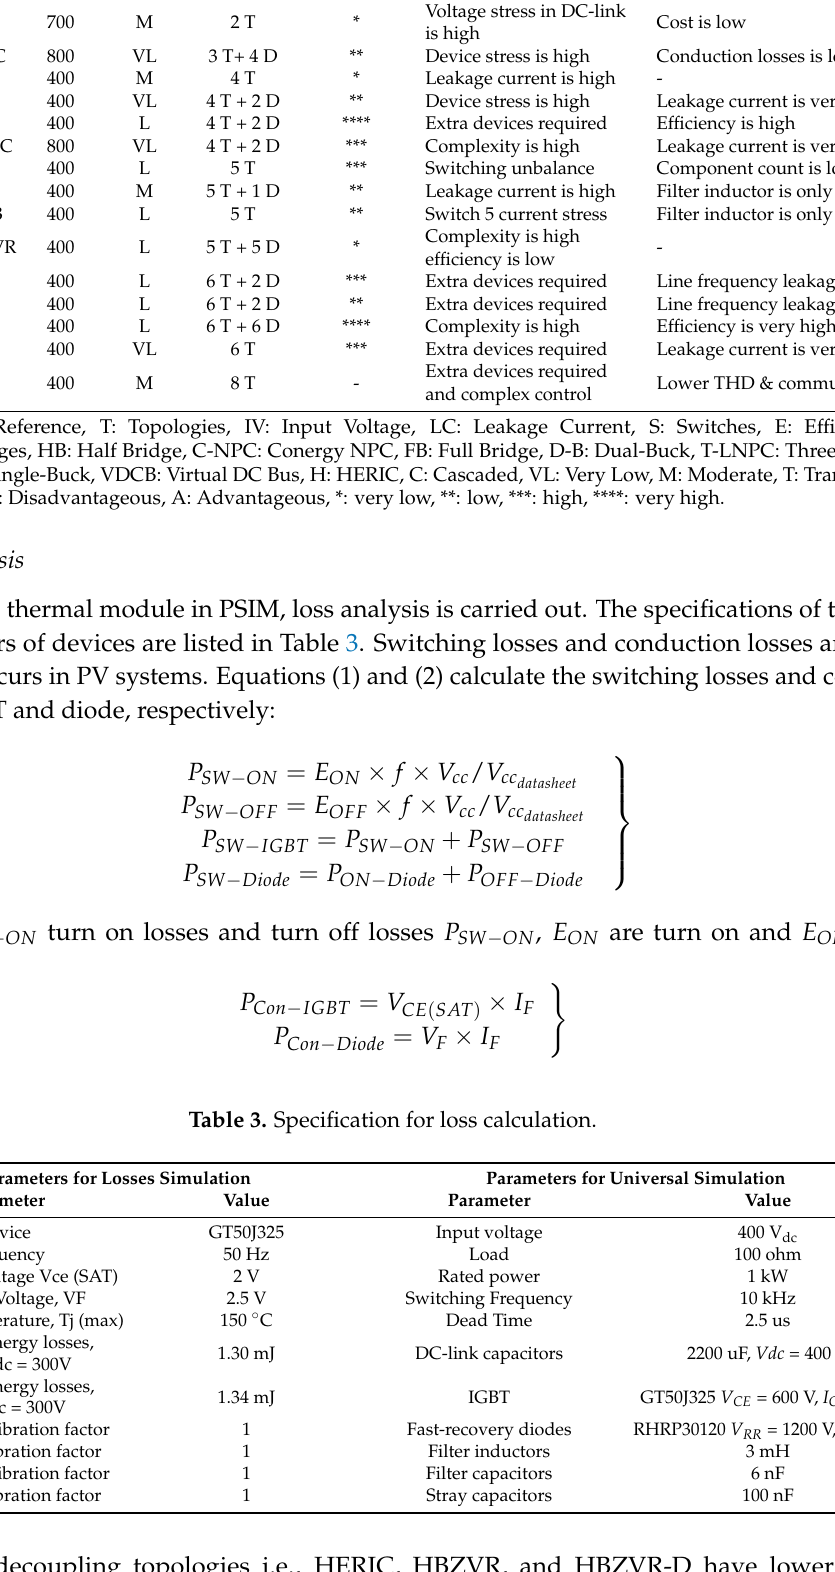
Table 2. Comparison of various transformerless inverter topologies [48,63,66,68,84–94]. R